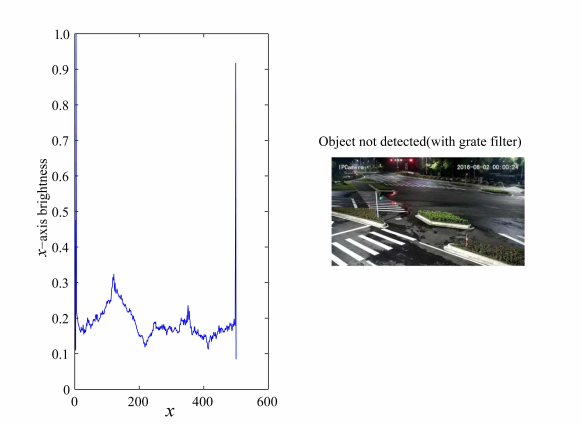
Fig. 18 Horizontal axis’ brightness values and search result (with grate filter) according to Fig. 16.